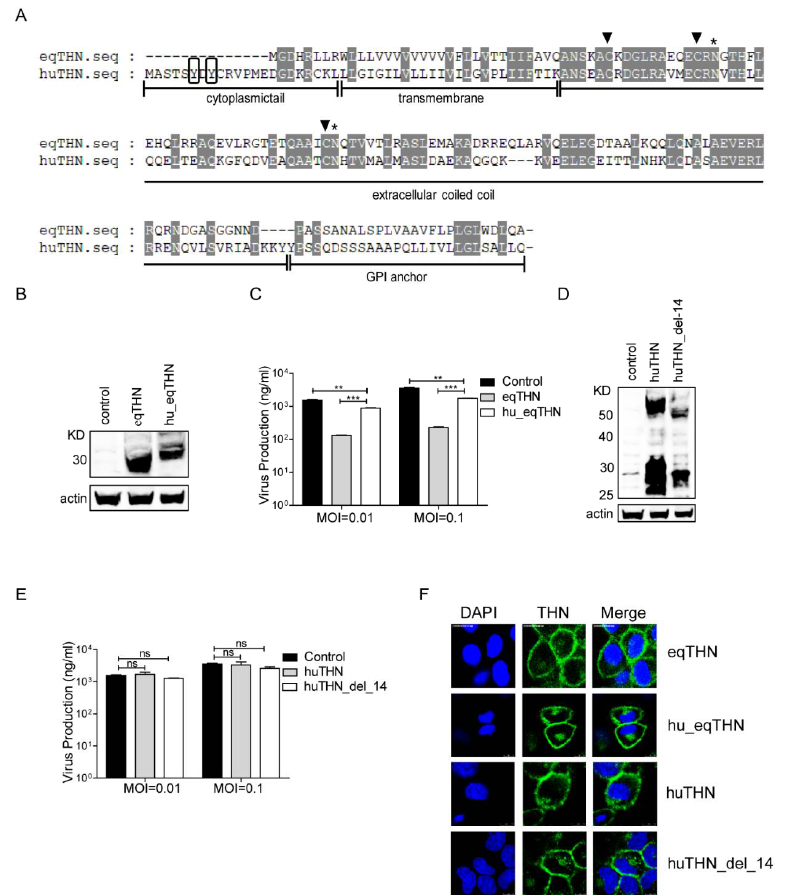
Figure 2. The shorter cytoplasmic tail domain of eqTHN contributed to its stronger restriction activity. ( A ) Amino acid sequence alignment of huTHN and eqTHN. The domains displayed include a cytoplasmic tail, a transmembrane region (TM), an extracellular coiled-coil domain, and a putative glycophosphatidylinositol (GPI) anchor. Identical amino acids are shaded in light gray. The dual tyrosine motif (Y6–Y8) at the cytoplasmic tail domain of huTHN is boxed in black. Three Cys residues in the extracellular domain are marked with black triangles. Two putative N-glycosylation sites in the extracellular domain are marked with asterisks; ( B ) Stable expression of HA-tagged hu_eqTHN in MDCK cells. Cells were lysed and the sample was treated as described for panel A in Figure 1; ( C ) The amount of SC09 released from MDCK, eqTHN-expressing and hu_eqTHN-expressing MDCK cells at 48 h post-infection at MOIs of 0.01 and 0.1. Infection and detection were carried out as described as above. The results of a single experiment performed with duplicate samples are shown, and results were subsequently confirmed in three separate experiments. Error bars indicate standard deviations (SD); ( D ) Stable expression of HA-tagged huTHN_del_14 in MDCK cells. Cells were lysed and the sample was treated as described for panel A in Figure 1; ( E ) The amount of SC09 released from MDCK, huTHN-expressing and huTHN_del_14-expressing MDCK cells at 48 h post infection with SC09 at MOIs of 0.01 and 0.1. Infection and detection were carried out as described as above. The results of a single experiment performed with duplicate samples are shown, and results were subsequently confirmed in three separate experiments. Error bars indicate standard deviations (SD); ( F ) Subcellular localization of tetherin and mutants on the cell surface with scale bars indicating 10 µ m. HA-tagged huTHN, eqTHN, huTHN_del_14 and hu_eqTHN-expressing MDCK cells were stained with an anti-HA antibody (green) and nuclei were stained with DAPI (blue). The cells were subsequently analyzed using confocal